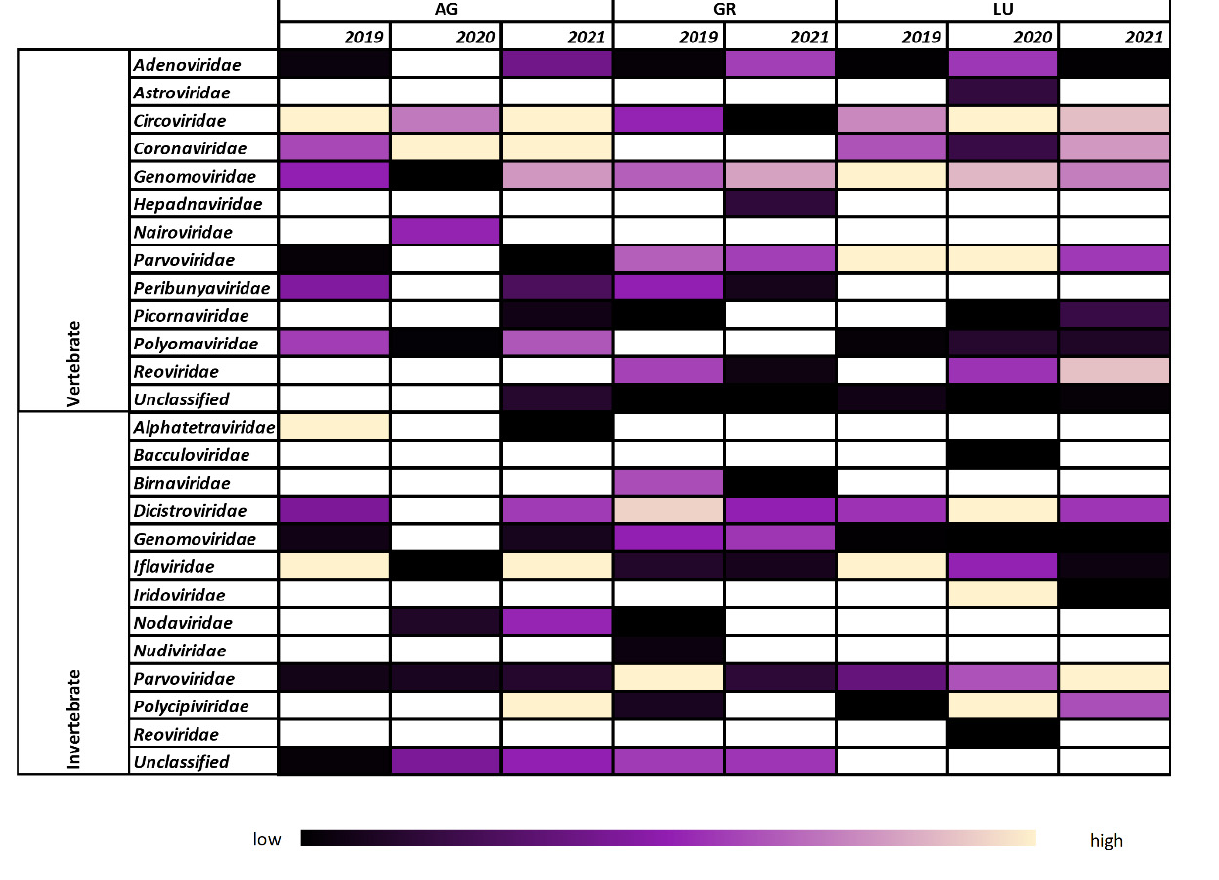
Figure 1. Overview of virus families from vertebrates and invertebrates detected in the Aargau (AG), Grisons (GR), and Lucerne (LU) colonies. The heatmap represents the relative number of viral reads from black (15th percentile of the lowest number) to purple (50th percentile) to light yellow (85th percentiles of the highest number). White = not detected.